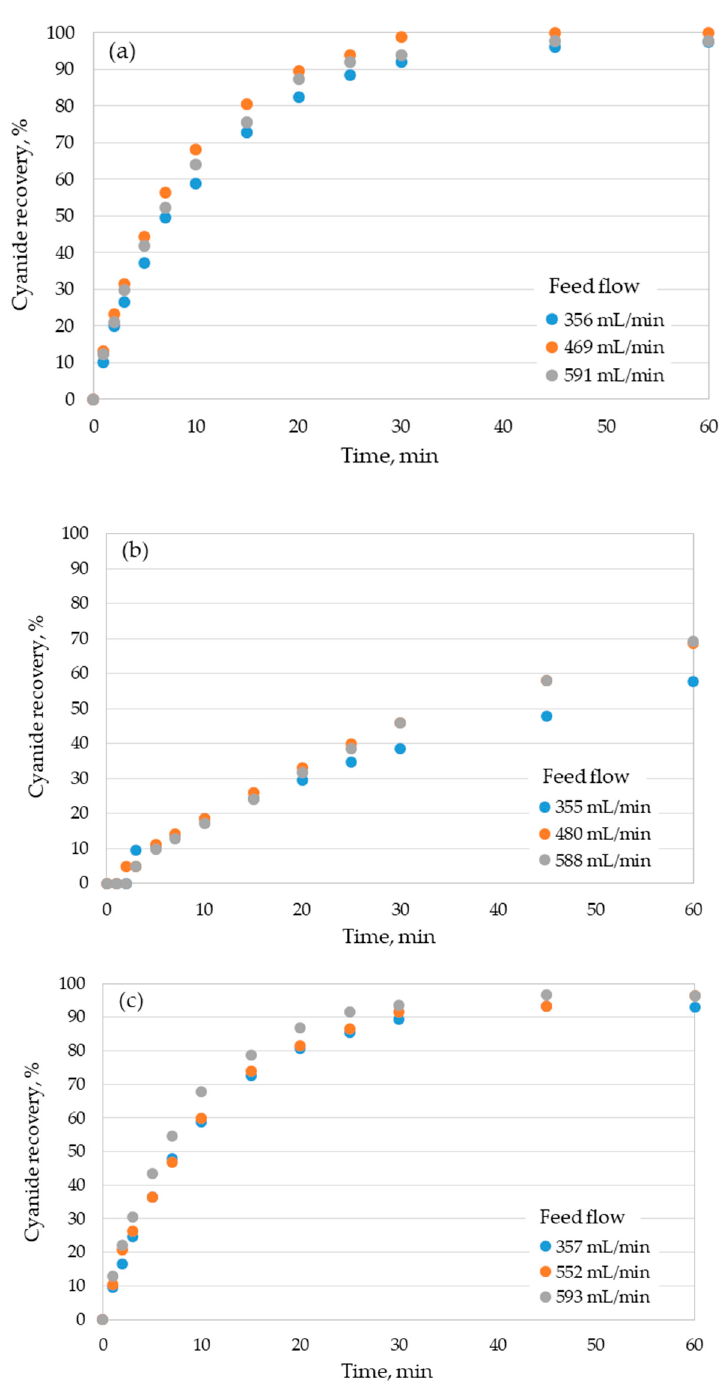
Figure 3. Cyanide recovery with the process time for each HFMC module operated at different feed flows and pH 3.5. ( a ) 1.7 × 5.5 Mini Module, ( b ) 1.7 × 10 Mini Module, and ( c ) 2.5 × 8 Extra Flow.